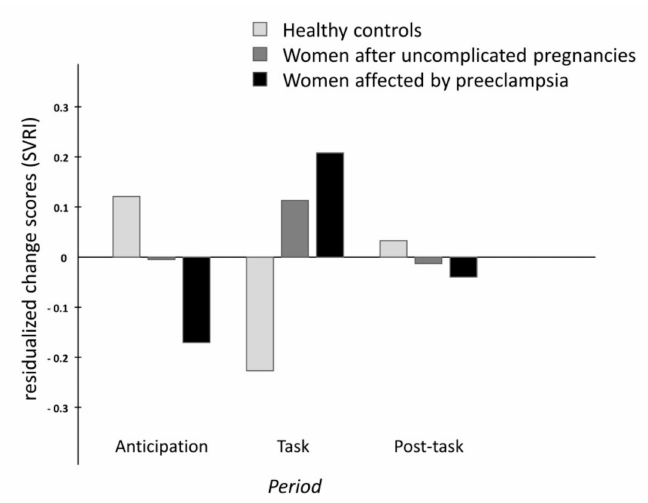
Figure 2. Barplot of the standardized residualized change scores for the systemic vascular resistance index